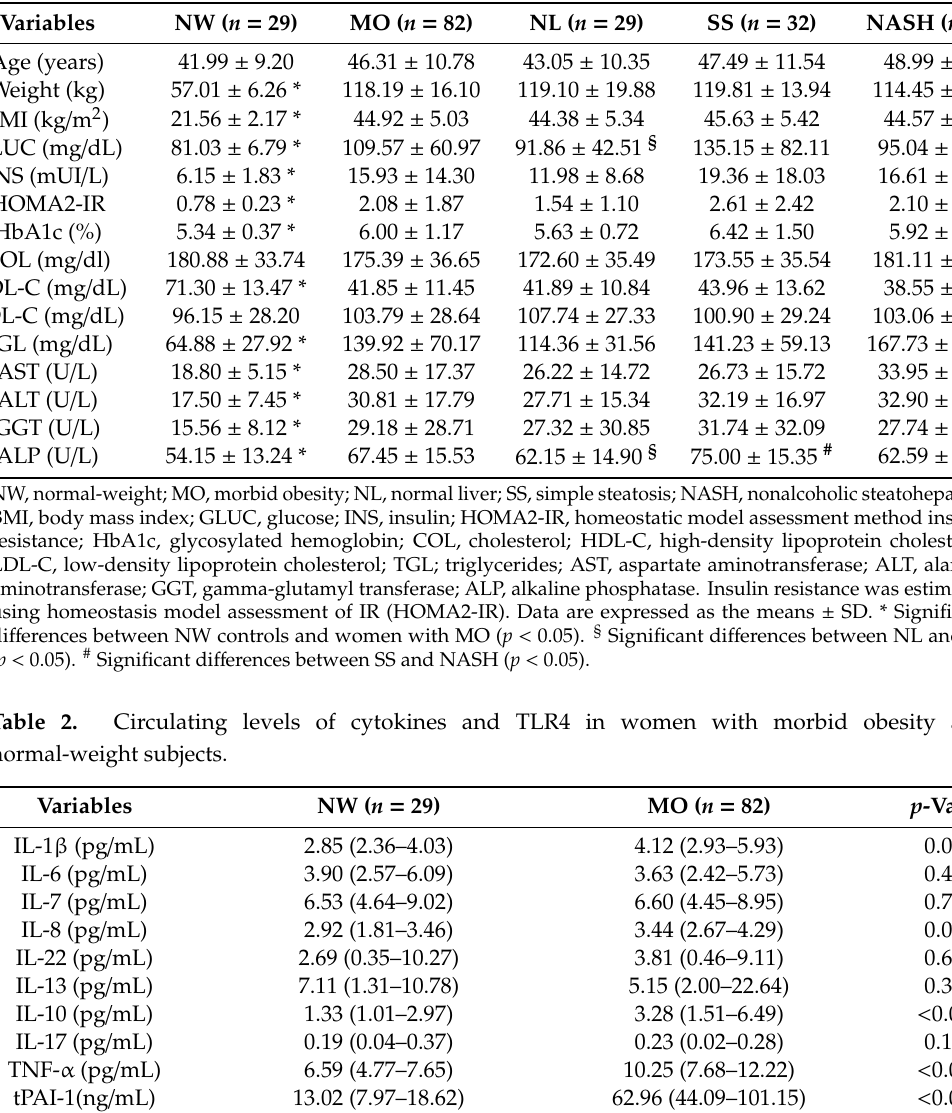
Table 1. Anthropometric and metabolic variables of study cohort classified according to BMI and histopathological characteristics.